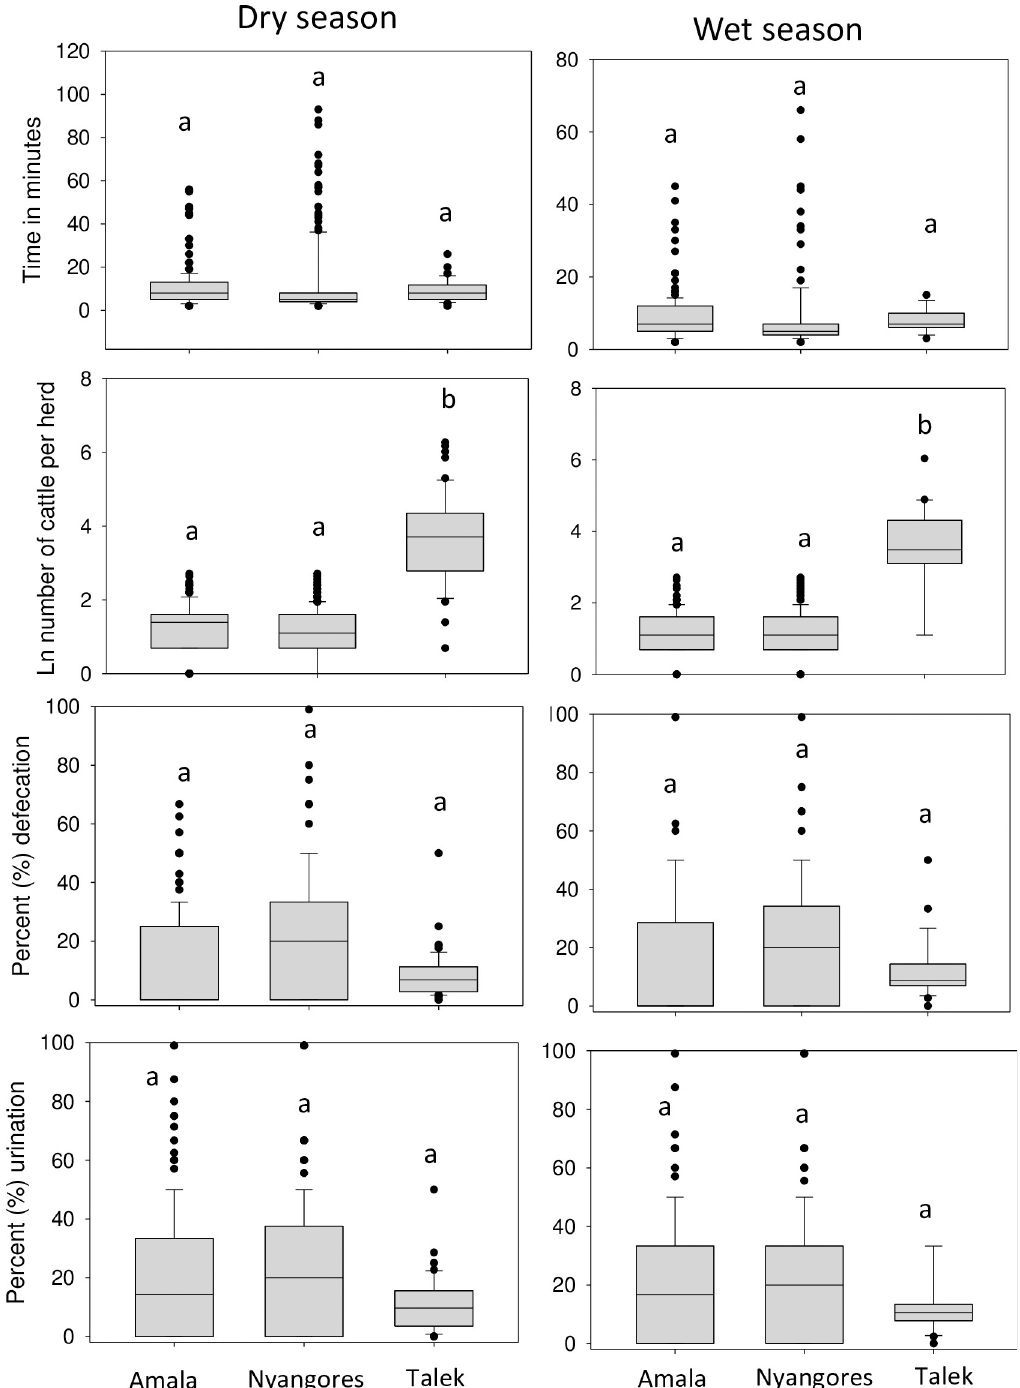
Fig 3. Livestock behaviour (time spent in the watering points, number of cattle per herd, % defecation and % urination) in the upper Mara River basin and lower basin in the Talek region during the wet and dry seasons.